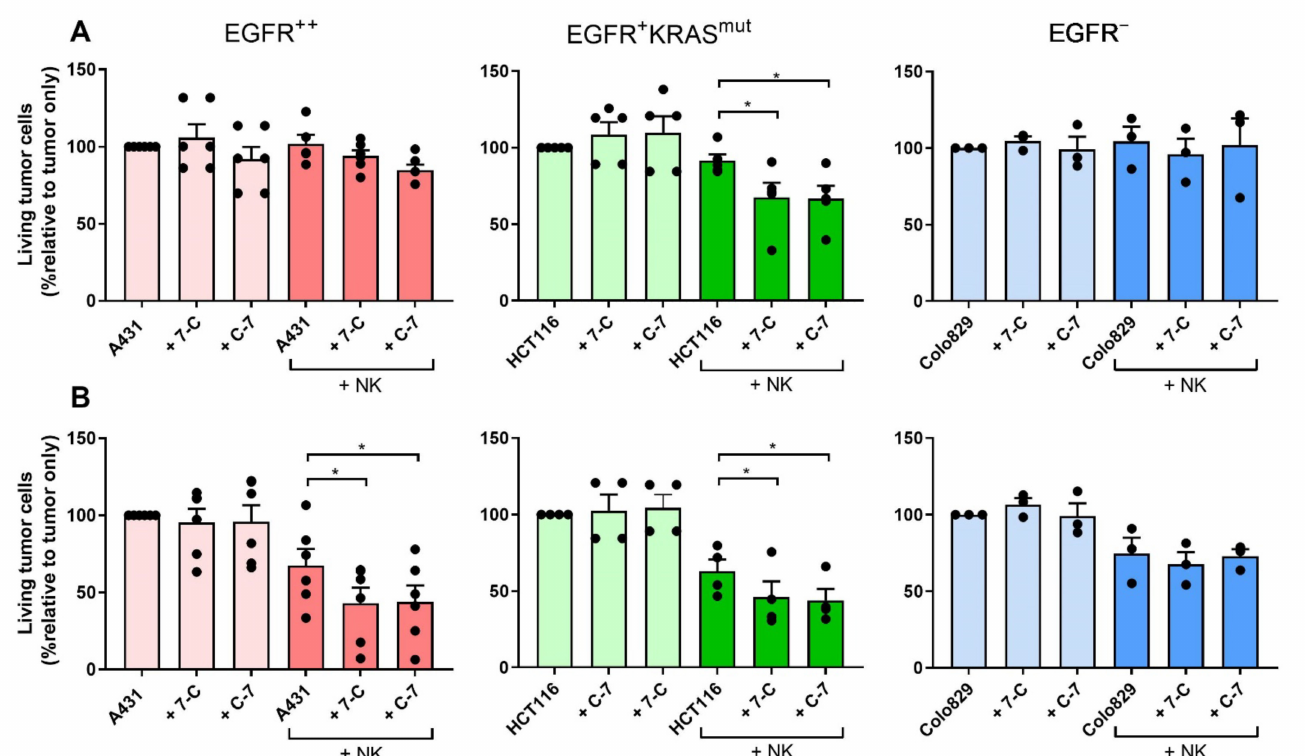
Figure 3. CD16-EGFR bispecific VHHs induce lysis of EGFR expressing tumor cells in the presence of NK cells. Cytotoxicity exerted by healthy donor-derived NK cells after a 24-h co-culture ± 100 nM bispecific VHHs ± tumor cell lines expressing different levels of EGFR: A431 (EGFR ++ ), HCT116 (EGFR + RAS mut ), Colo829 (EGFR − ). ( A ) Resting NK cells were used as effectors; ( B ) NK cells were pre-activated overnight with IL-2 and IL-15. Cytotoxicity was determined by assessing the relative percentage of living tumor cells compared to the tumor-alone condition. E:T ratio: 1:1. The bars represent mean ± SEM. Significance is presented as p < 0.05 *. A431 n = 6 ( A , B ); HCT116 n = 5 ( A ) and n = 4 ( B ); Colo829 n = 3 ( A , B ). p -values were determined by a two-tailed paired t -test. Abbreviations: C-7 = C21-7D12 bispecific VHH, 7-C = 7D12-C21 bispecific